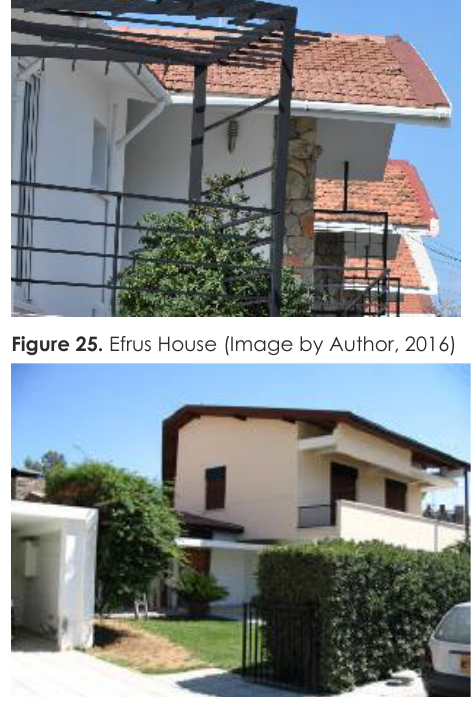
Figure 26. Ferdi Macit House MACIT FERDI HOUSE, NICOSIA 1961 ( D.Celik,without date).